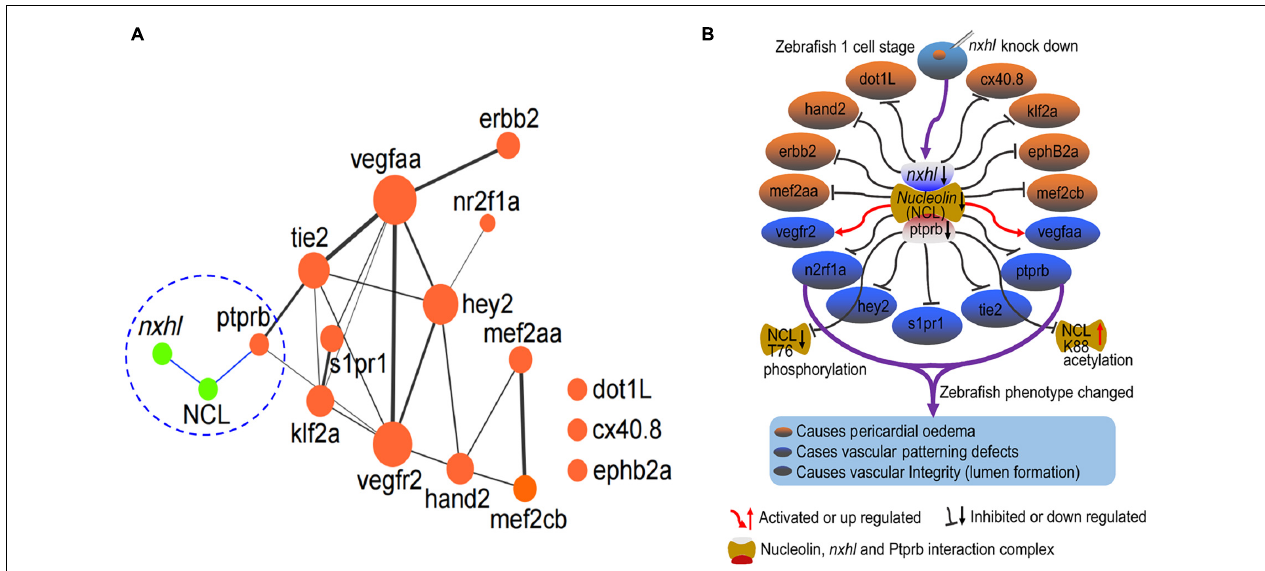
FIGURE 8 | Nxhl controls angiogenesis by targeting VE-PTP ( ptprb )-related angiogenic genes. (A) Schematic model illustrating the mechanism of nxhl in zebrafish angiogenesis and heart development. The interactions between nxhl mRNA and NCL protein, NCL protein and ptprb mRNA are new-found interactions in this study. It connects with the keystone network of angiogenesis and heart development. (B) Possible mechanism of nxhl in zebrafish angiogenesis and heart development. Knockdown of nxhl may downregulate the nxhl -NCL- ptprb complex, subsequently regulate the proteins associated with angiogenesis and heart development, and finally result in heart pericardial edema, vascular patterning and integrity